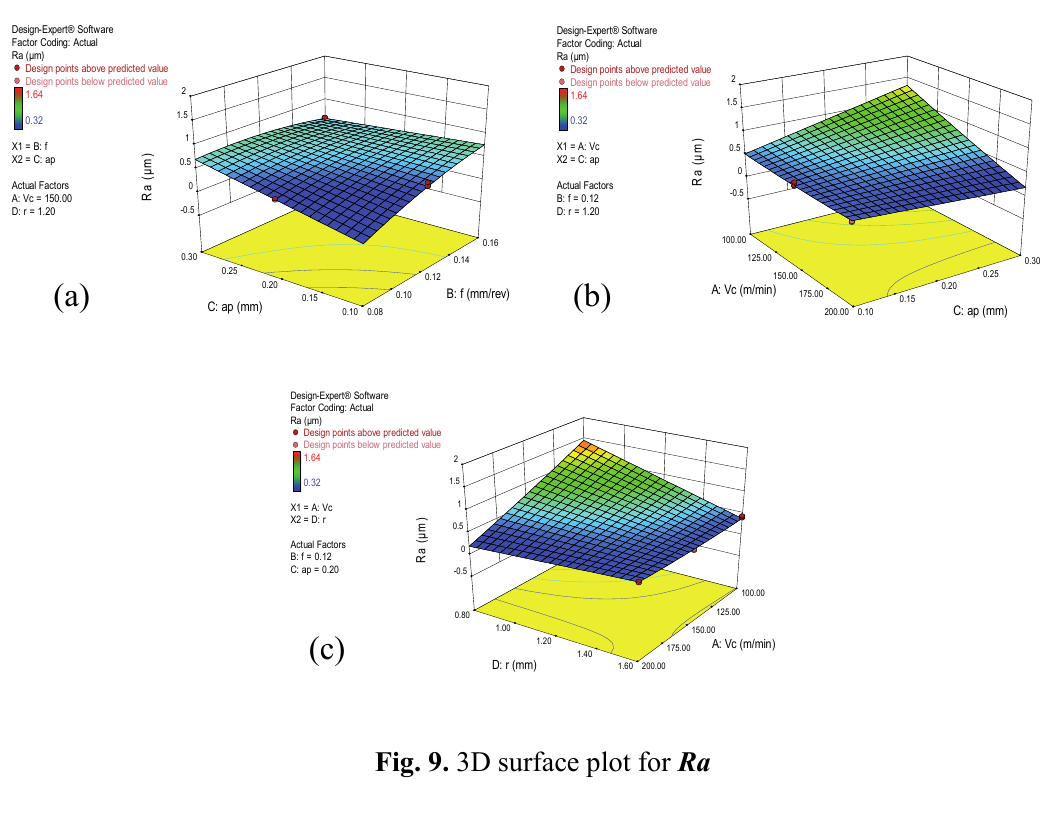
Fig. 9. 3D surface plot for Ra